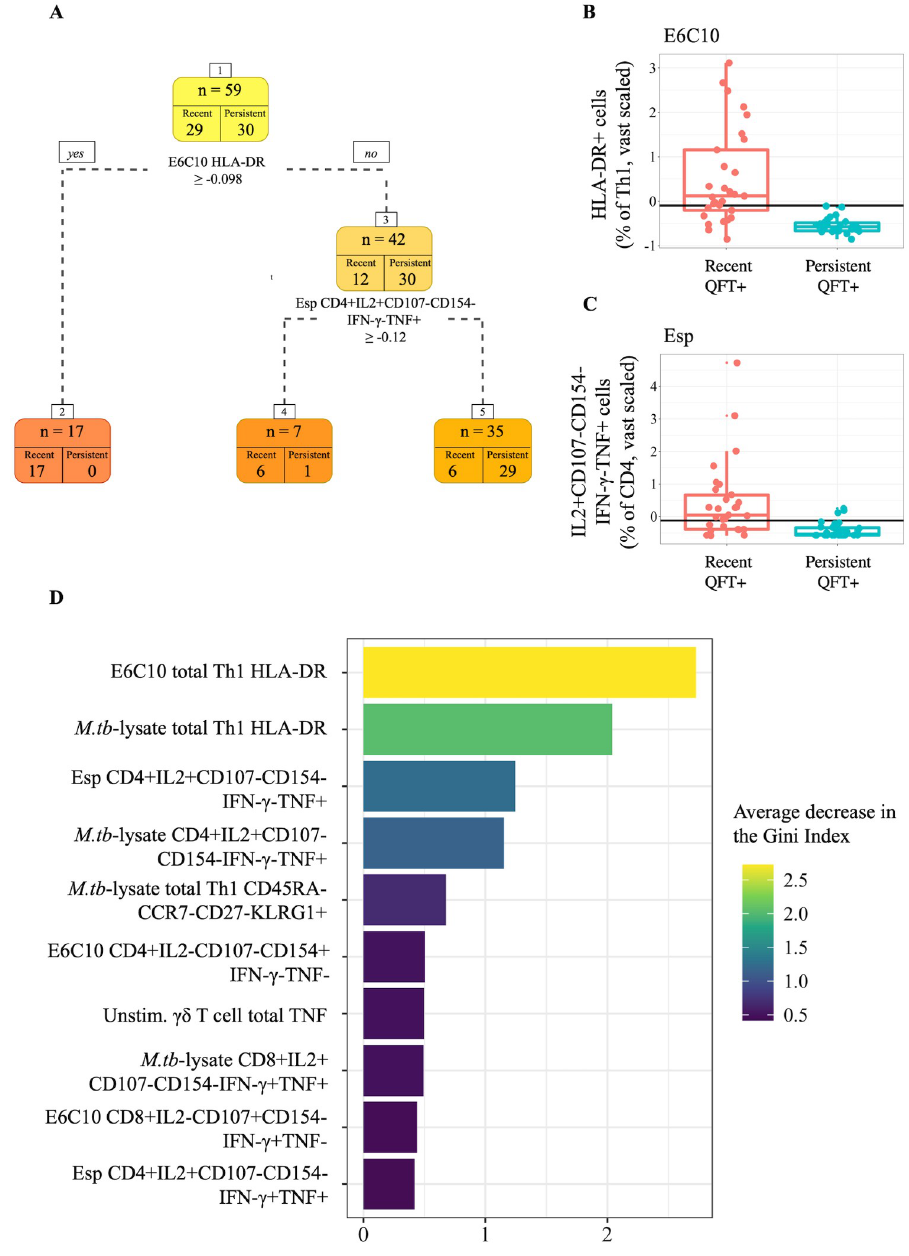
Fig 3. Tree-based modeling results. (A) Results from the simple classification tree built to the entire integrated dataset. Boxplots comparing vast scaled values of recent (red) and persistent (blue) QFT+ individuals were plotted for the two most stratifying features identified by the decision tree. The split values are superimposed onto the plots at (B) -0.098 for proportions of E6C10-specific Th1 cells expressing HLA-DR, and (C) -0.12 for frequencies of Esp-specific IL2+CD107-CD154-IFN- γ -TNF+ CD4+ T cells. (D) Variable importance plot of the final RF model showing the top 10 variables that resulted in the largest average decrease in the Gini Index.